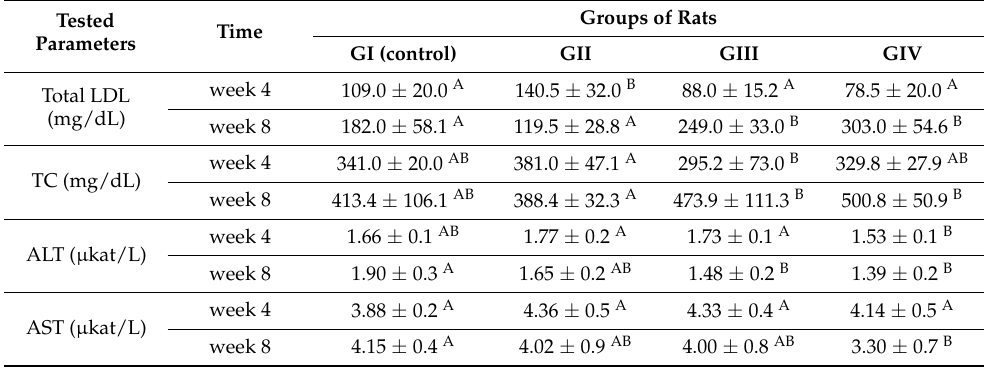
Table 5. LDL and TC (as determined using the Lipoprint ® LDL System) and enzyme aminotransferases. Tested